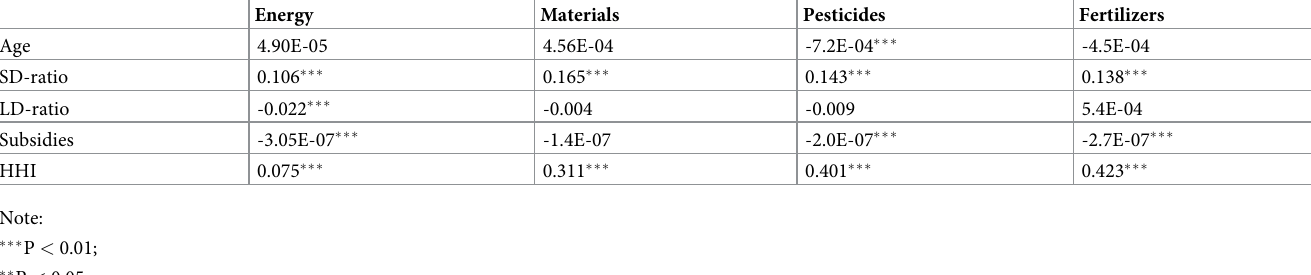
Table 3. Marginal effects on the inefficiency of the separate